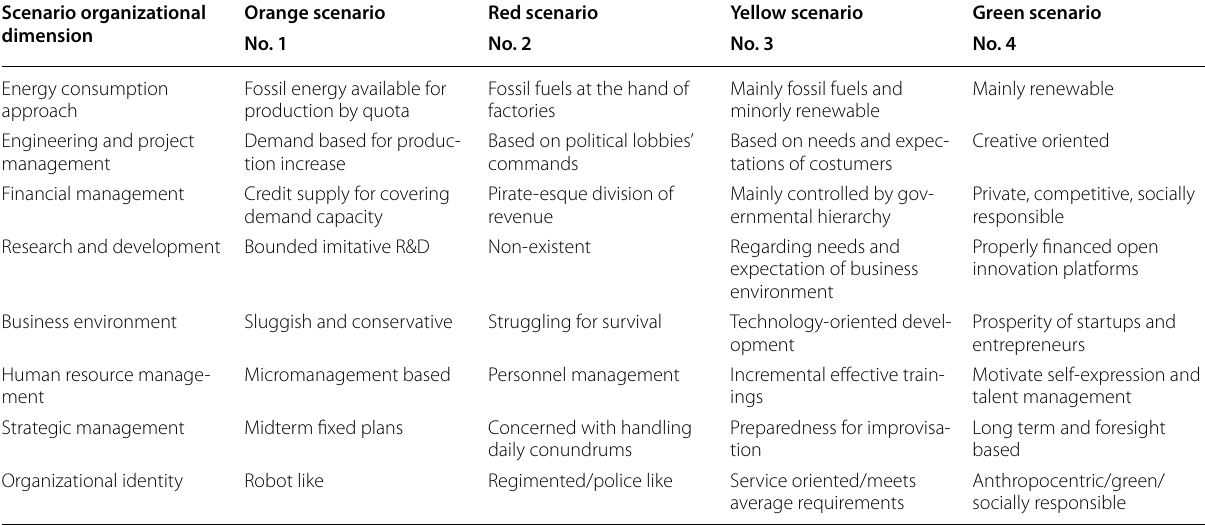
Table 6 Some reimagined organizational dimensions of Esfahan Pack Co. in 4 scenarios Scenario organizational dimension